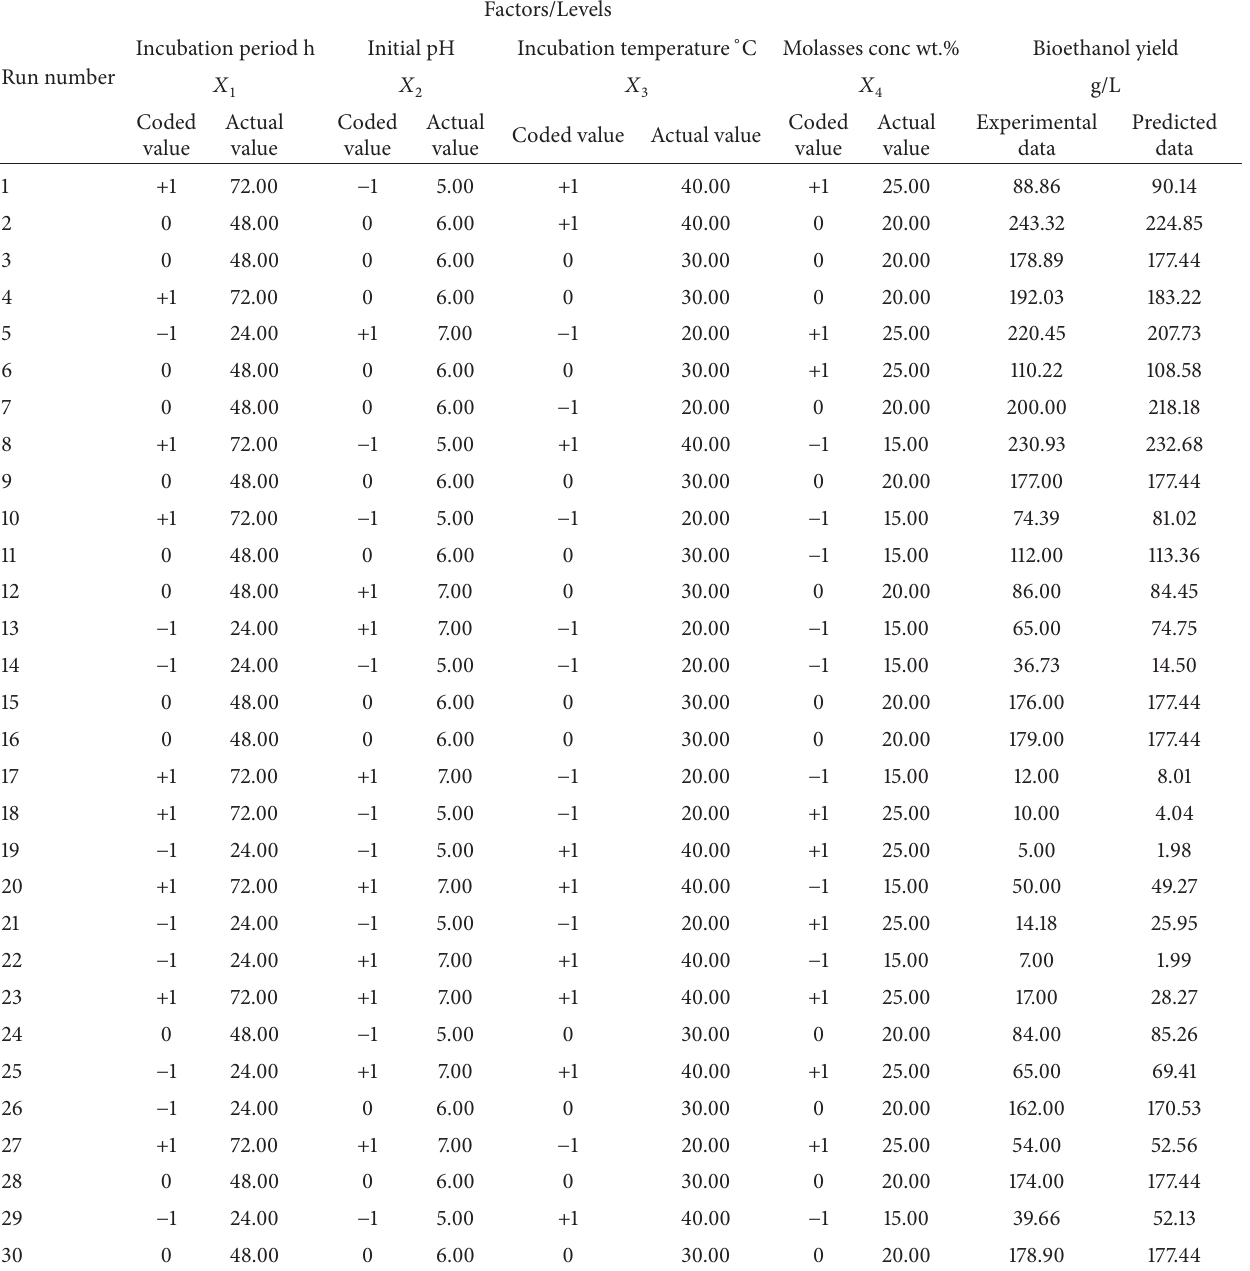
Table 2: Experimental design matrix with experimental and predicted values of bioethanol